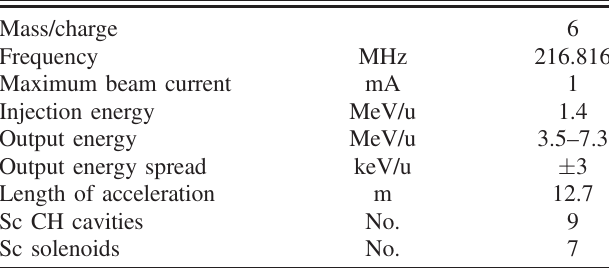
TABLE I. Design parameters of the cw